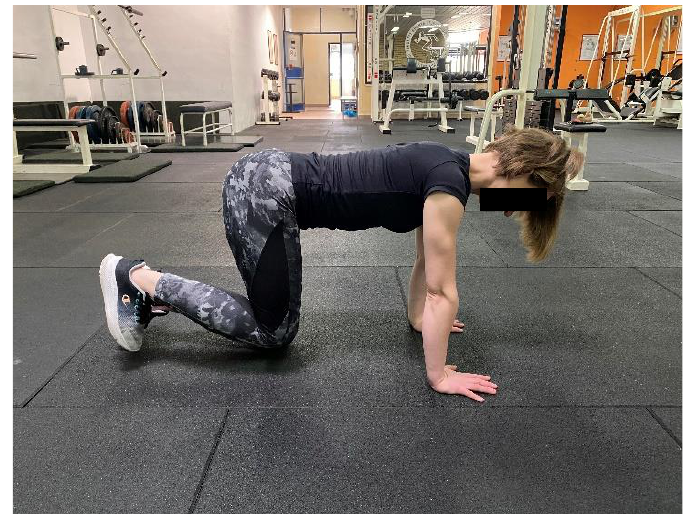
Figure 3. 3-Point Quadripod Exercise (3-PQE).